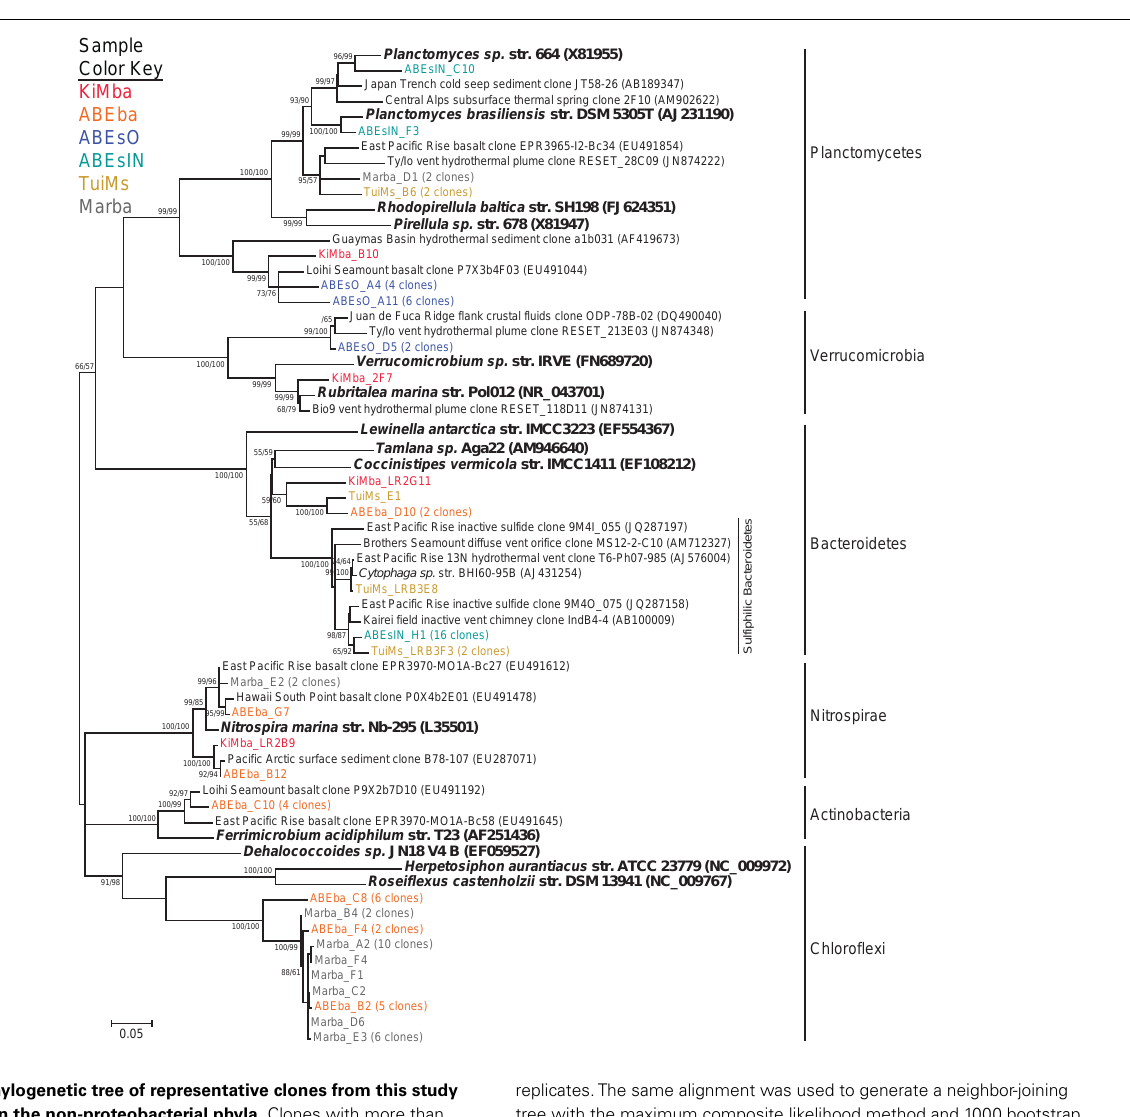
FIGURE 7 | Phylogenetic tree of representative clones from this study that fall within the non-proteobacterial phyla. Clones with more than one representative, or for which multiple members fell into a single clade, were chosen. Numbers in parentheses after some clones indicate total number of clones represented by the single clone depicted.The tree was generated in MEGA 5 using the maximum likelihood method with the Jukes-Cantor model and a Gamma distribution and 1000 bootstrap